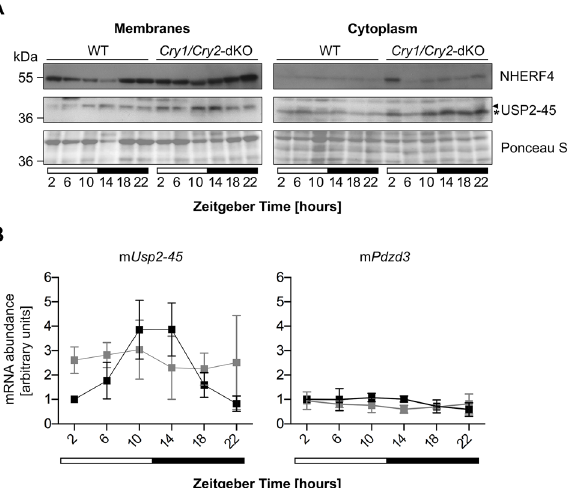
around the clock. In turn, NHERF4 is not down or up-regulated but keeps a lower amplitude post-transcriptional rhythm (Fig 6A). These data indicate that the levels of NHERF4 have an